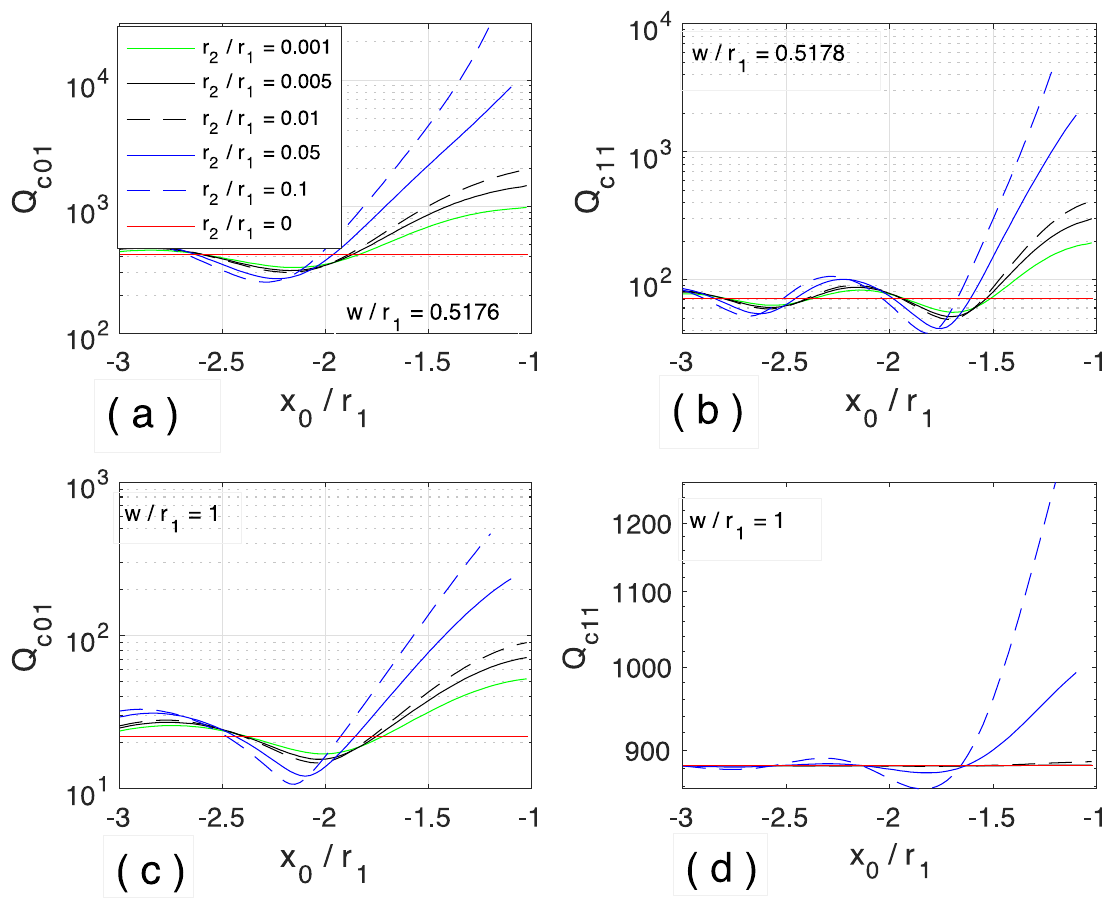
Figure 4. 𝑄 factor of the symmetric modes 𝑇𝑀 (cid:3030)(cid:2868)(cid:2869) , 𝑇𝑀 (cid:3030)(cid:2869)(cid:2869) versus relative distance 𝑥 (cid:2868) 𝑟 (cid:2869) ⁄ for slotted Figure 4. Q factor of the symmetric modes TM c 01 , TM c 11 versus relative distance x 0 / r 1 for slotted cavities ( w / r 1 ≈ 0.5176, 1) in a presence of outside wires ( r 2 / r 1 = 0.001, 0.005, 0.01) and thin circular cylinders ( r 2 / r 1 = 0.05, 0.1): ( a ) Q c 01 , w / r 1 ≈ 0.5176; ( b ) Q c 11 , w / r 1 ≈ 0.5176; ( c ) Q c 01 , w / r 1 = 1; ( d ) Q c 11 , w / r 1 =